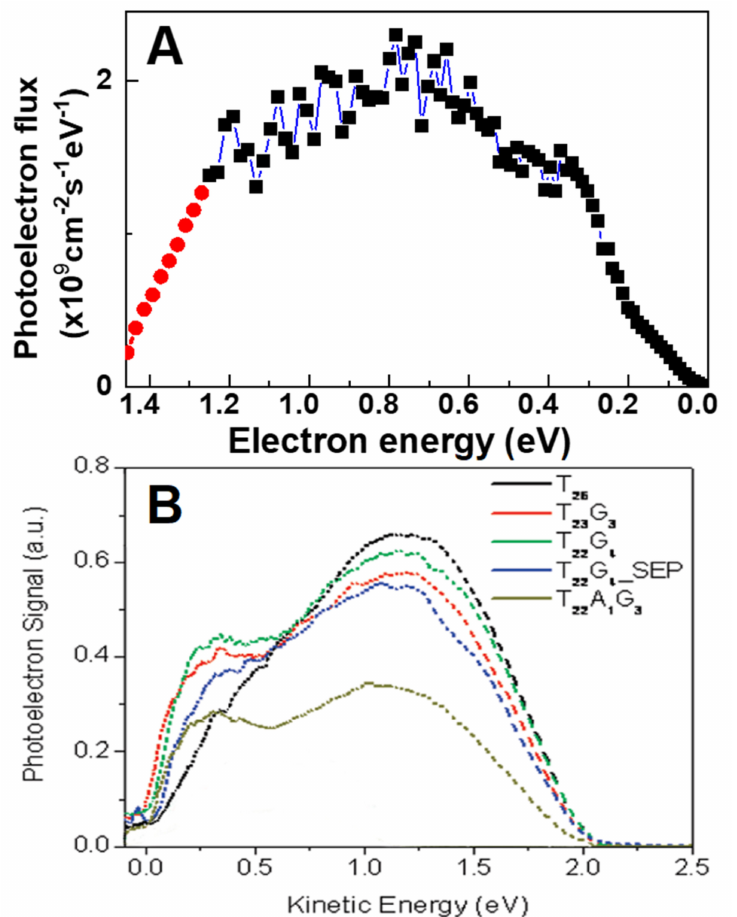
Figure 3. ( A ) The energy distribution of photoelectron flux calculated with Folwer’s law with the work function of 3.7 eV for the Ta − DNA surface irradiated with Xenon lamp [41] Copyright 2016 by American Chemical Society. ( B ) Energy spectra of photoelectrons transmitted through self-assembled monolayers of oligonucleotides of various compositions and sequences anchored to a gold surface. The photoelectrons were emitted by 6.42 eV photons striking the surface. The oligomers are anchored to the substrate by a thiolate terminal group [89]. Each transmission spectrum from different DNA oligomer is represented by a different color. T 22 G 4 -SEP indicates that each of the four guanines (G) is separated by 3 thymines (T), while in the other oligomers the Gs are clustered. Adapted from